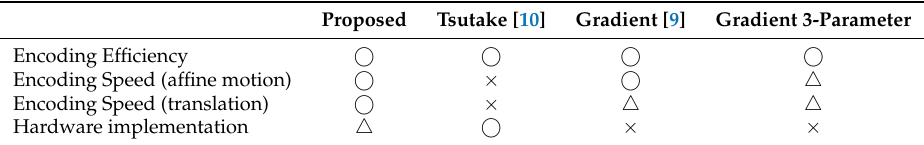
Table 6. Overview of Advantages and Disadvantages of Each Method. (cid:13) marks when the method is effective, (cid:52) when it is acceptable, and × when it is inadequate for this